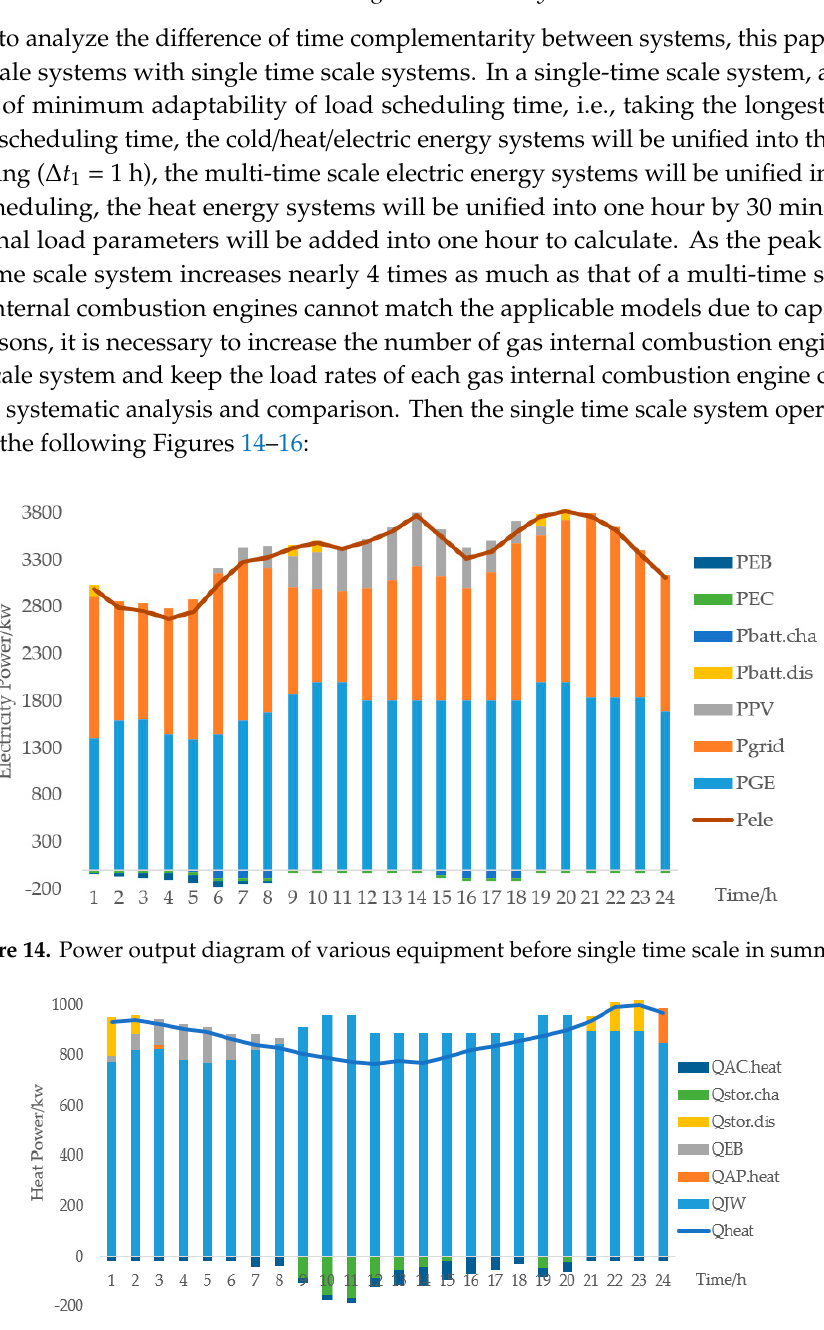
Figure 15. Heat output diagram of various equipment before single time scale in summer.